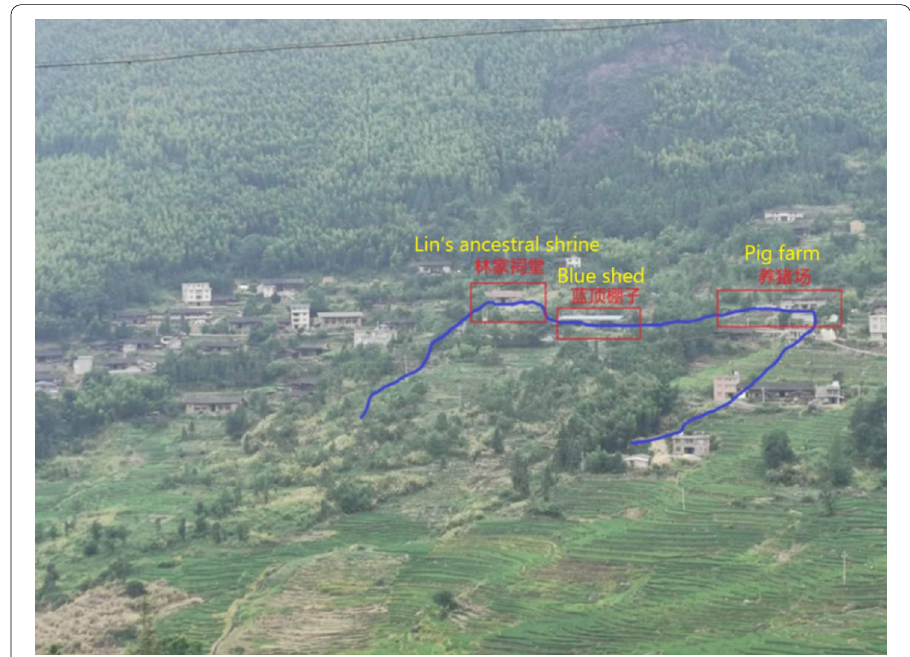
Fig. 3 Approximate perimeter of the Lianhe terraces